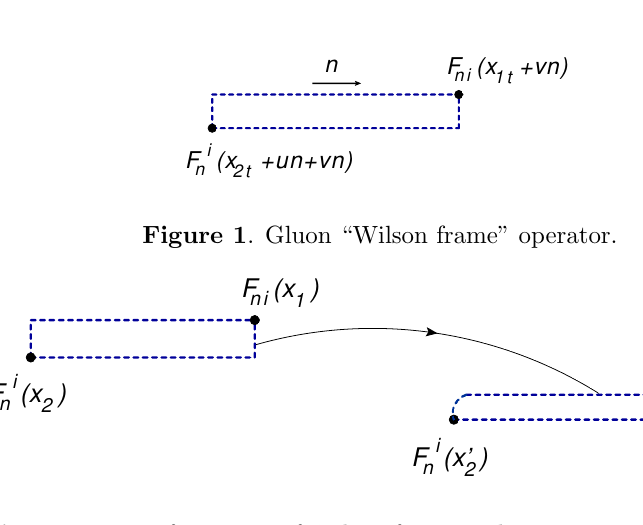
Figure 2 . Transformation of Wilson frame under inversion x (cid:22) ! x (cid:22) =x 2